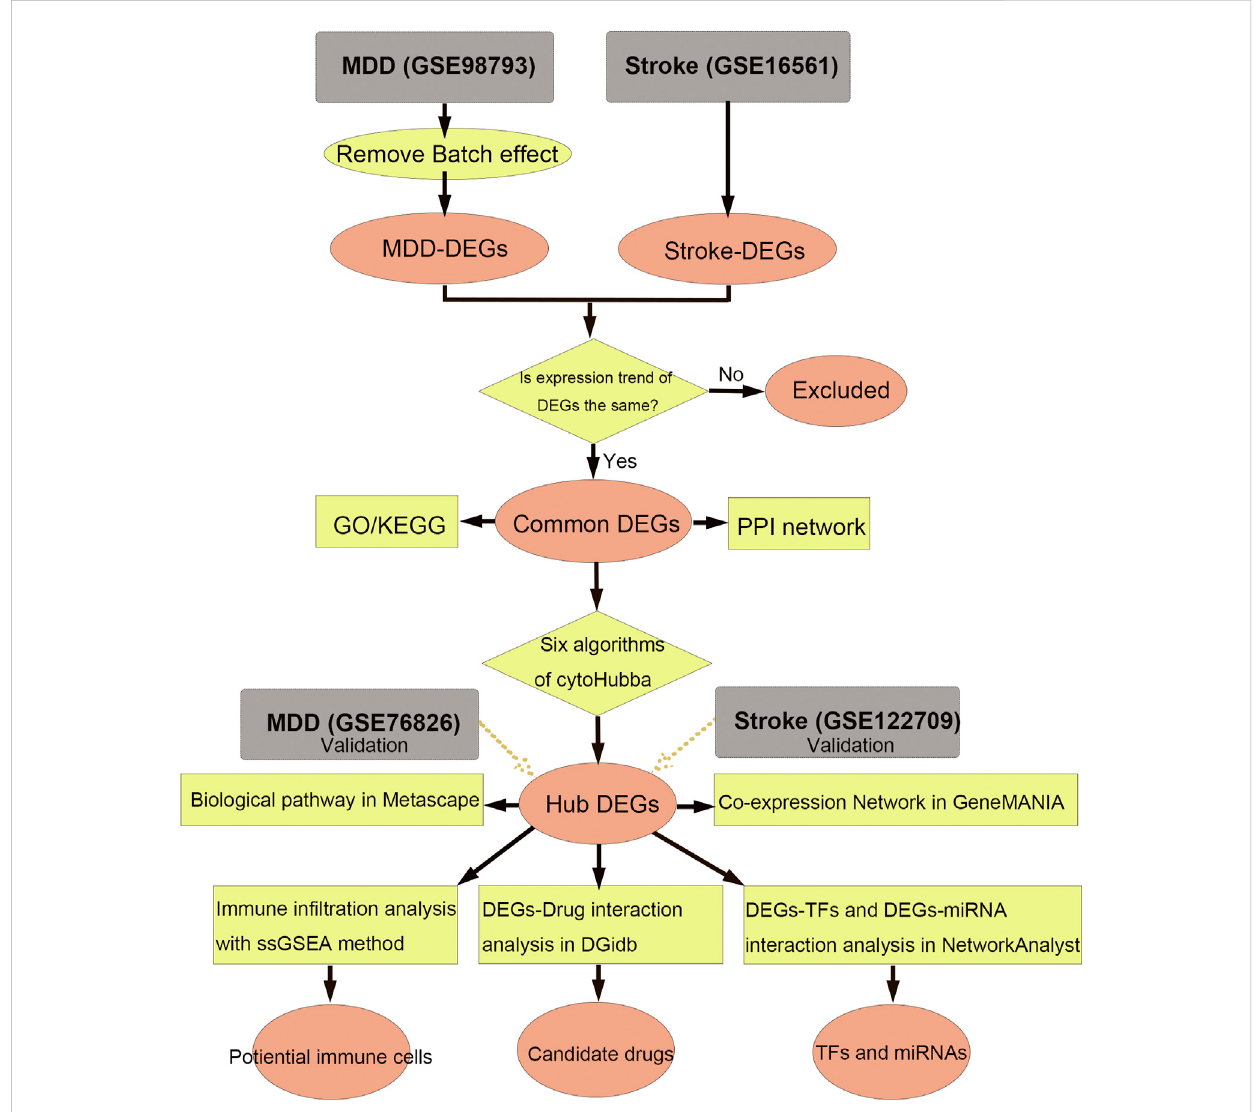
FIGURE 1 Work fl owofdataanalysisinourpresentwork.MDD,majordepressivedisorder;DEGs,differentiallyexpressedgenes;ssGSEA,singlesamplegeneset enrichment analysis; TF, transcription factor; GO, Gene Ontology; KEGG, Kyoto Encyclopedia of Genes and Genomes; PPI, protein-protein